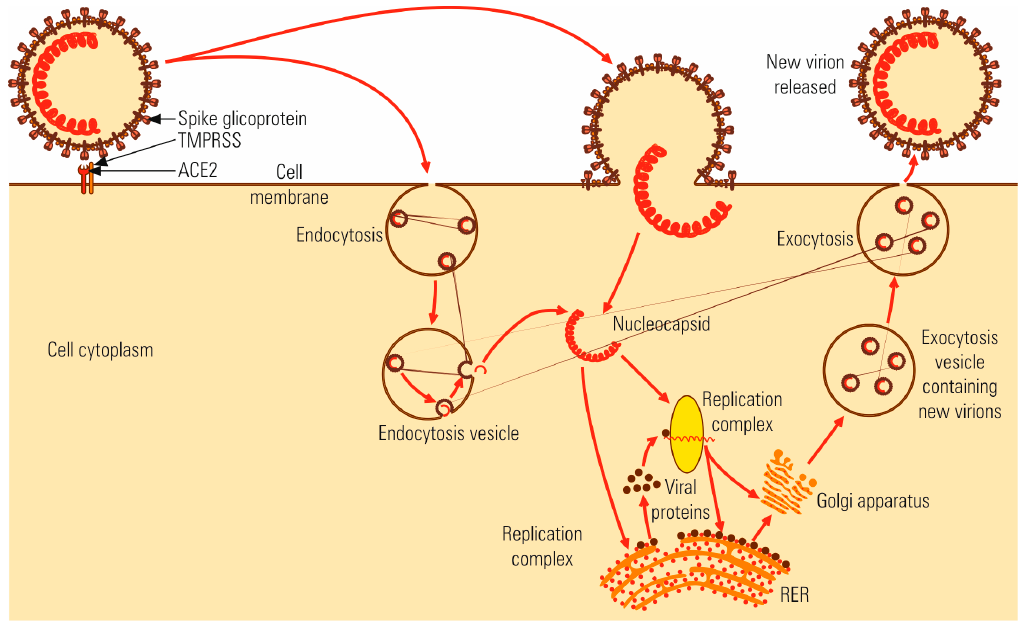
Figure 2. Schematic representation of coronaviruses multiplication cycle.